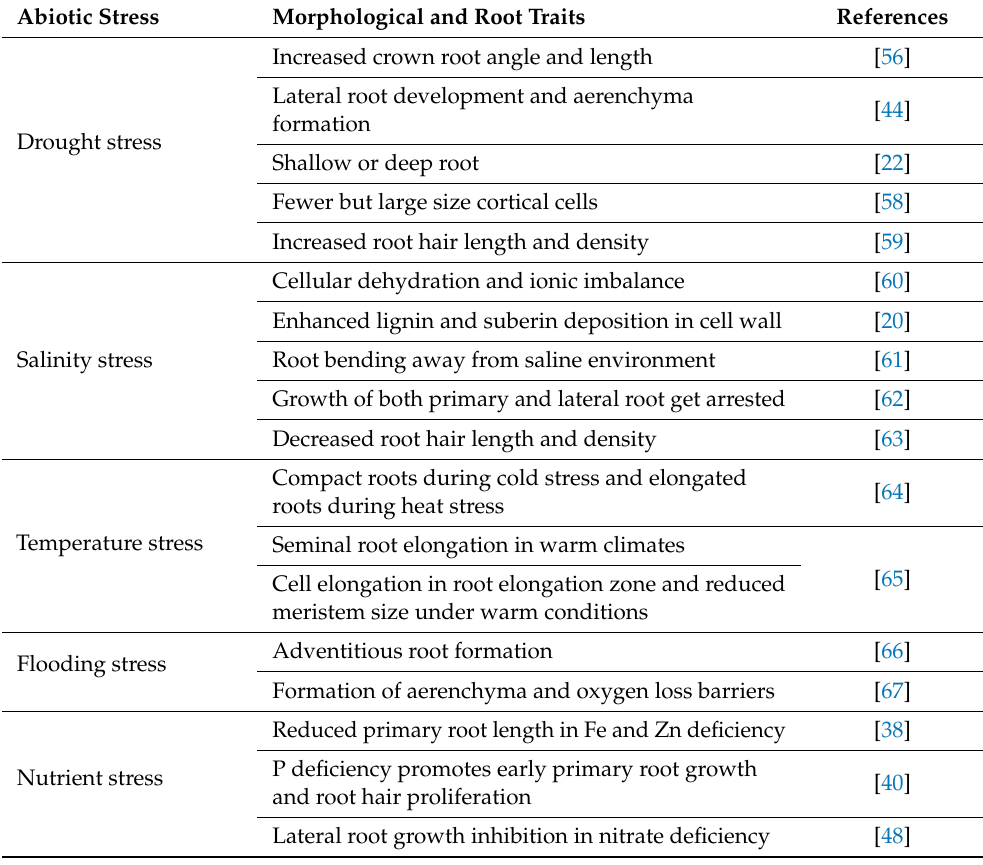
Table 2. Role of different root traits in abiotic stress tolerance. Abiotic Stress Morphological and Root